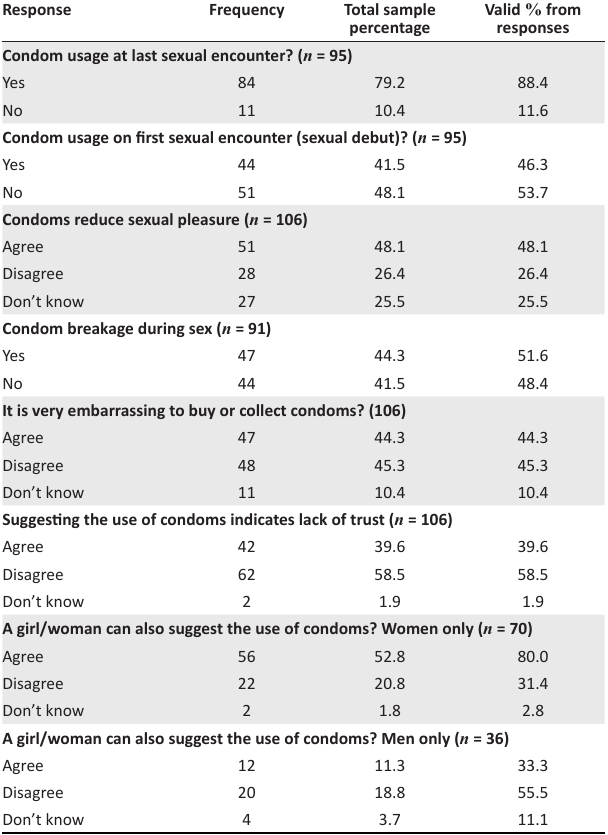
TABLE 1: Condom (both male and female condoms) usage, practices, and beliefs.